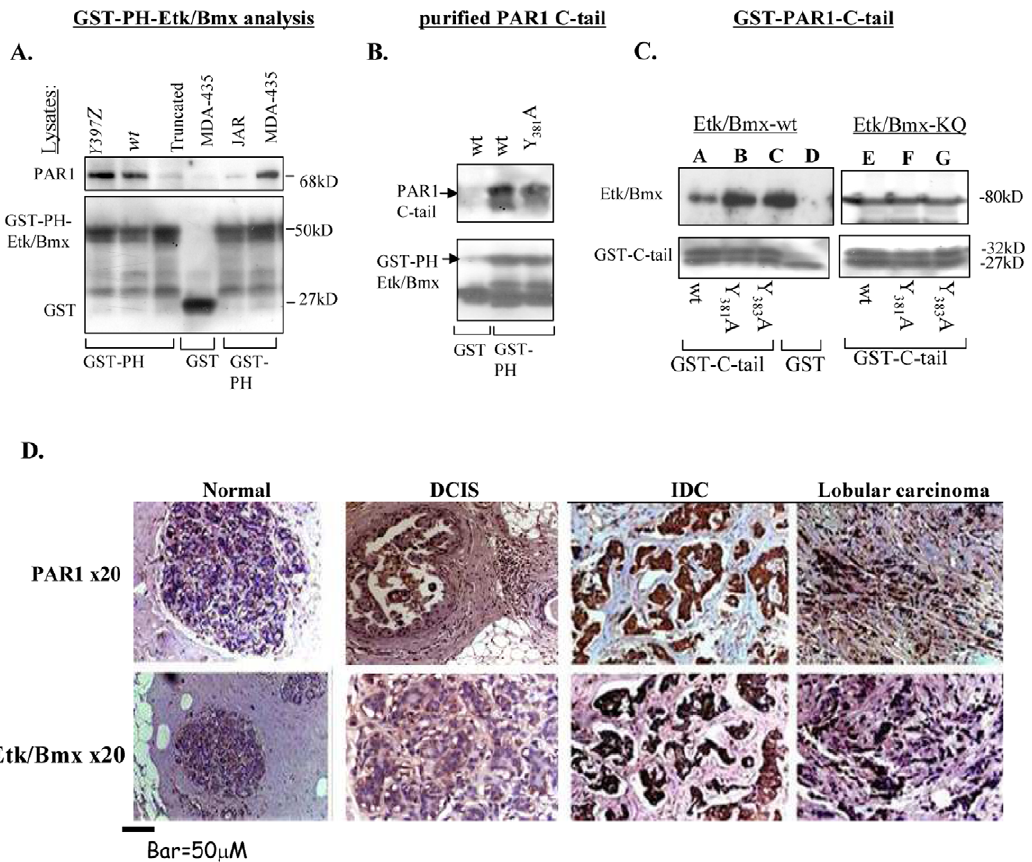
Figure 5. Physical association between PAR 1 and Etk/Bmx. A . PAR 1 is physically associated with Etk-PH domain. Lysates of cells over-expressing Y397Z , wt or truncated hPar1 , and lysates of cells that do not express PAR 1 (e.g., JAR) were applied to a GST-Etk-PH column. Noticeably, highly metastatic MDA-435 cells express high levels of PAR 1 Specifically-bound proteins were detected using anti- PAR 1 antibodies. While Y397Z and wt hPar1 showed specific PAR 1 association, lysates of the truncated hPar1 or JAR cells showed no binding. B . Purified PAR 1 C-tail. PAR 1 C-tail was cleaved from the immobilized GST-C-tail, purified and re-applied onto a GST-Etk-PH domain column. Specific binding is observed regardless of whether purified wt or mutant cleaved C-tail is analyzed. No binding was observed when only GST beads were used. C . GST- PAR 1 C-tail of wt and mutants. Lysates of HEK293 cells transfected with either Etk/Bmx (A–D) or kinase-inactive Etk/Bmx (KQ; E–G), applied on various GST-PAR 1 -C-tail columns (PAR 1 -C-tail of wt , Y 381 A , Y 383 A ) or GST-control column. The GST-C-tails from either wt hPar1 or mutants Y 381 A and Y 383 A are strongly associated with both wt (A–D) and kinase- inactive (KQ; E–G) Etk/Bmx. Control-free GST did not show any binding of KQ Etk/Bmx (data not shown). Specifically-bound proteins were